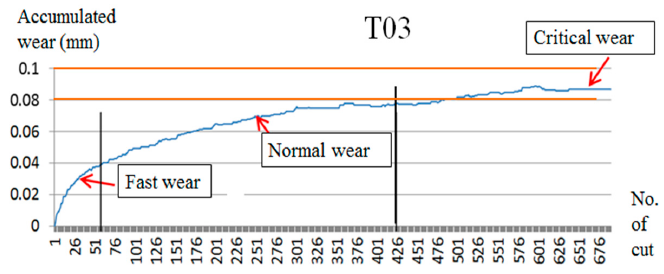
Figure 5. Tool wear vs. number of cuts of T03.